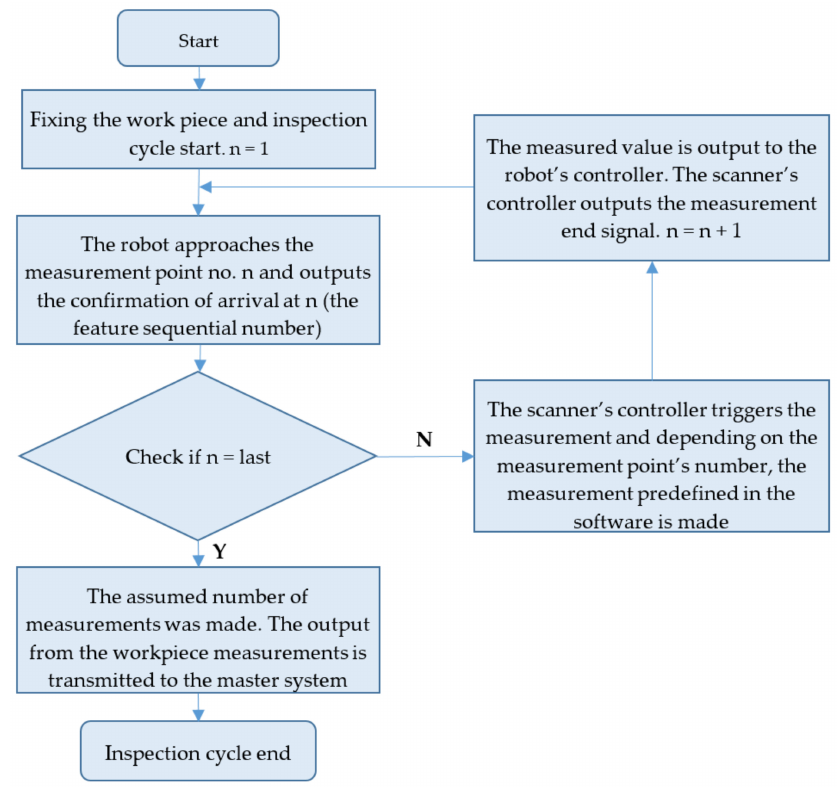
Figure 7. Operating algorithm of the robotised inspection